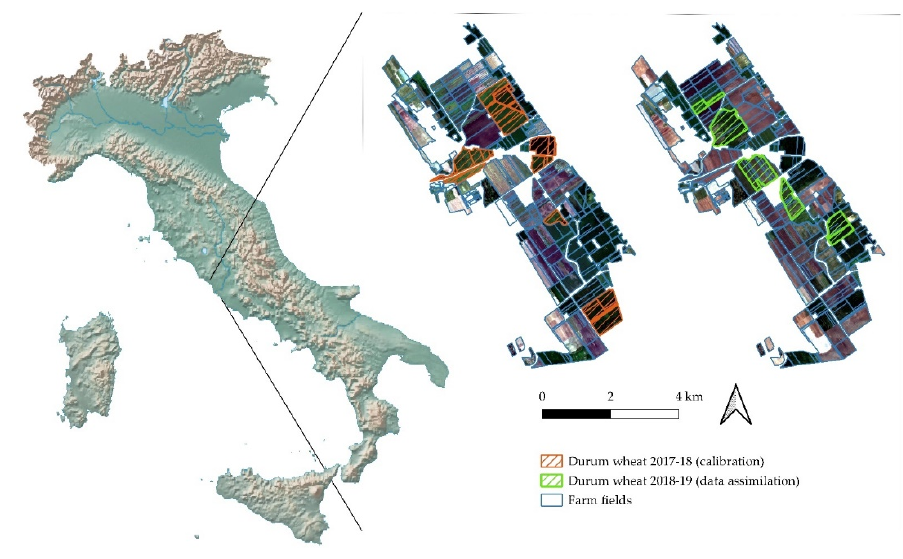
Figure 1. Maccarese farm area and durum wheat fields’ locations. Durum wheat fields of the 2017–2018 growing season were used for calibration, whereas durum wheat fields of the 2018–2019 growing season for data assimilation. RGB Sentinel-2 images (https://scihub.copernicus.eu/ accessed on 13 April 2020) of 6 April 2018 and 22 March 2019 were used as a base layer for the field.